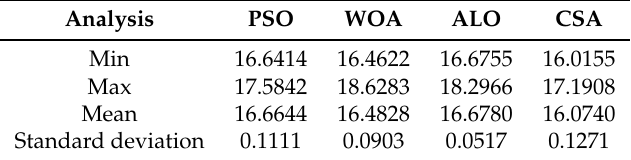
Table 7. Results of real power loss P loss (MW) for IEEE 30-bus test.